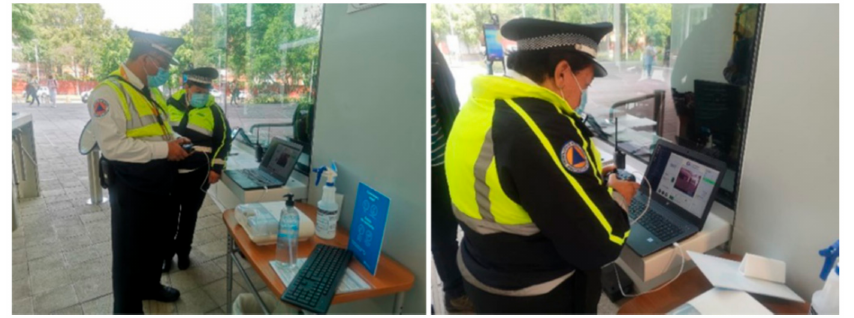
Figure 29. A remote terminal controls